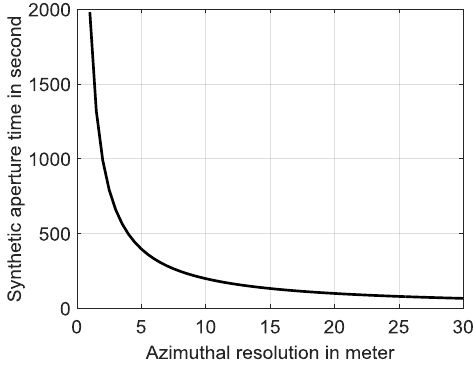
Figure 12. Relationship between the exposure time and azimuthal resolution. Here, the declination of the moon is set to 28.5 degrees.